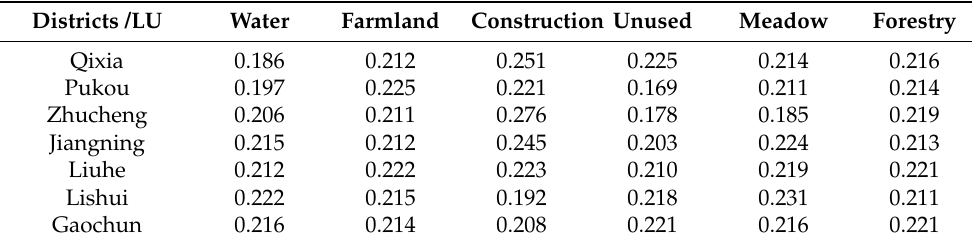
Table 4. The FoM accuracies of LU simulation in different districts by the proposed model. Districts /LU Water Farmland Construction Unused Meadow